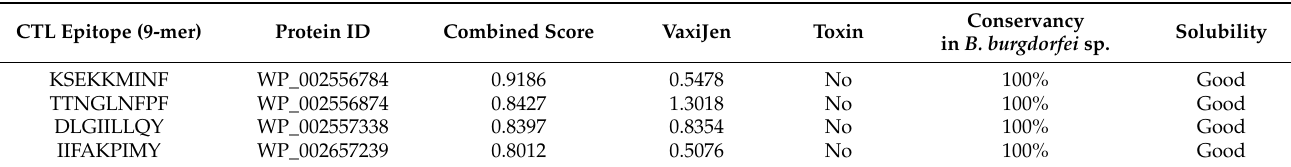
Table 2. A shortlist of CTL epitopes to be used in the final vaccine design.